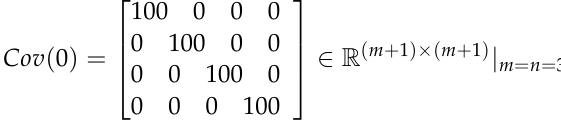
Figure 5. Tracking errors. It takes a little longer to learn to control the sideslip angle and bank angle than the attack angle. This can be attributed to the stronger coupling characteristics between the roll and yaw channels.